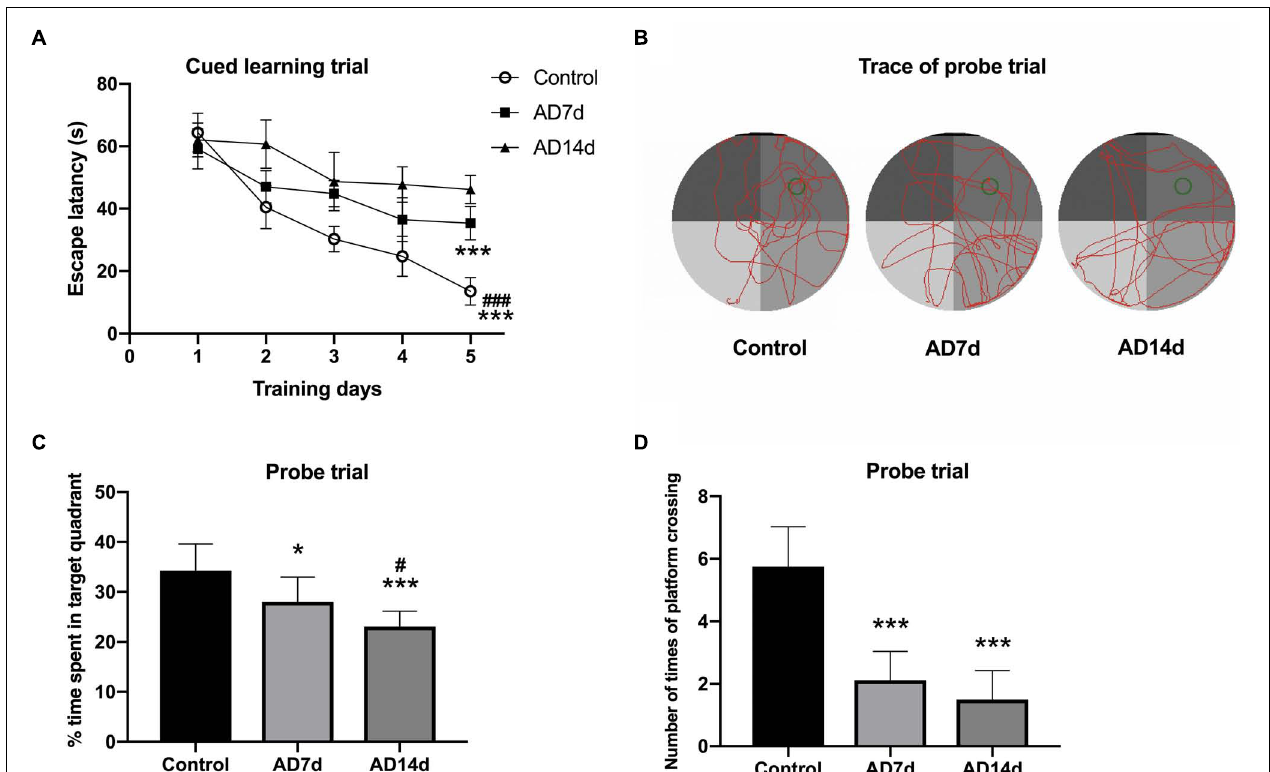
FIGURE 1 | Administration of A β 1 - 42 induces cognitive impairment. Following A β 1 - 42 injection, the three groups of rats (7 days for Control and AD7d group, 14 days for AD14d group) were evaluated for spatial learning and memory in the MWM test. (A) Mean daily latencies to escape from the start point onto the hidden platform in the cued learning trail. (B) Representative path traces during the probe test. (C) Percent of time spent in the target quadrant relative to total time in the pool during the probe trial. (D) Number of crossings of the target platform during the probe trial. n = 9 per group, mean ± standard deviation, ∗ P < 0.05, ∗∗∗ P < 0.001 vs. Control group, group. # P < 0.05, ### P < 0.001 vs.